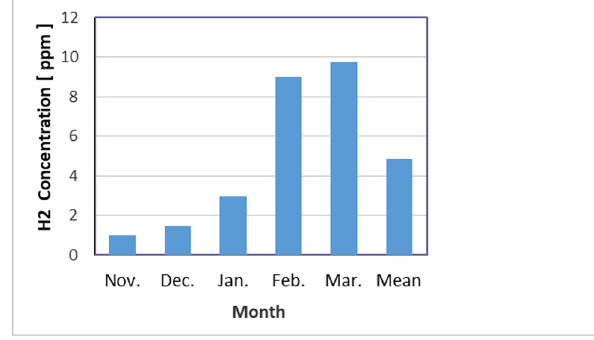
Figure 6: Monthly concentrations and overall mean of H 2 gas during the study period.